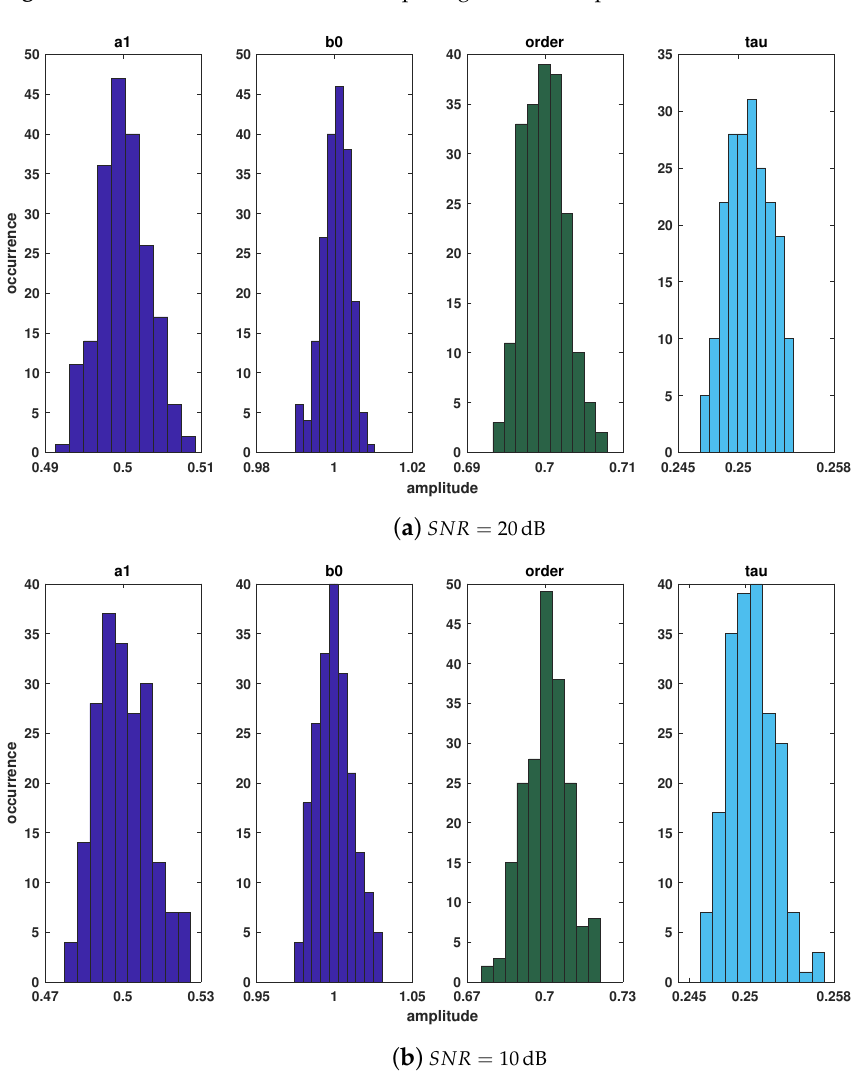
Figure 5. The histograms of the process estimates of example 1 with the FOSTD - OE algorithm SNR y = 20and10 [dB] nmc =